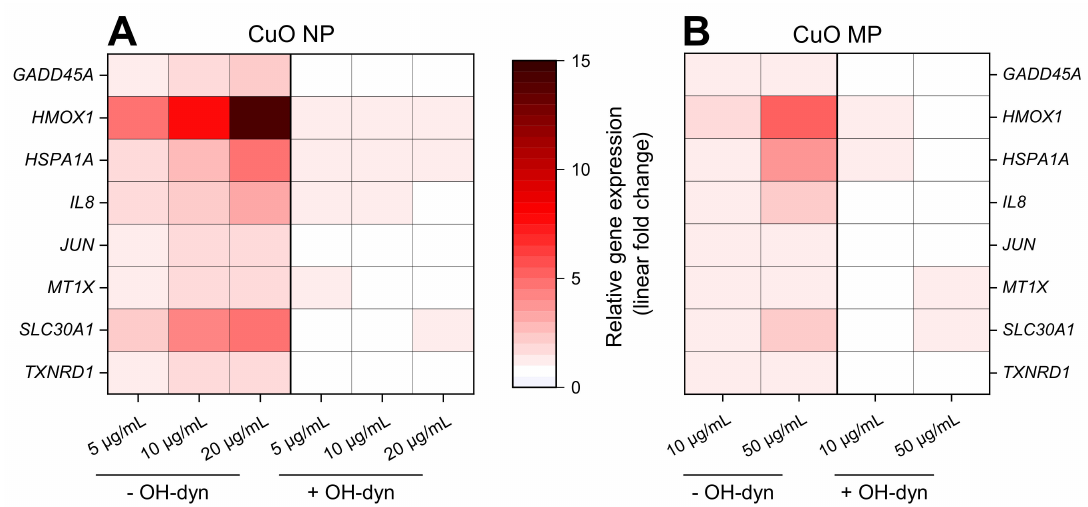
Figure 4. Impact of CuO NP ( A ) and CuO MP ( B ) on gene expression patterns related to copper homeostasis, (oxidative) stress, DNA damage and inflammation in the absence or presence of OH-dyn. BEAS-2B cells were treated with the di ff erent copper compounds with or without OH-dyn for 8 h. Shown are linear-fold changes of the relative gene expression in a heat map view from mean values of four determinations derived from two independent experiments (expression level of control = 1). Exact values including standard deviations are provided in supplementary Table